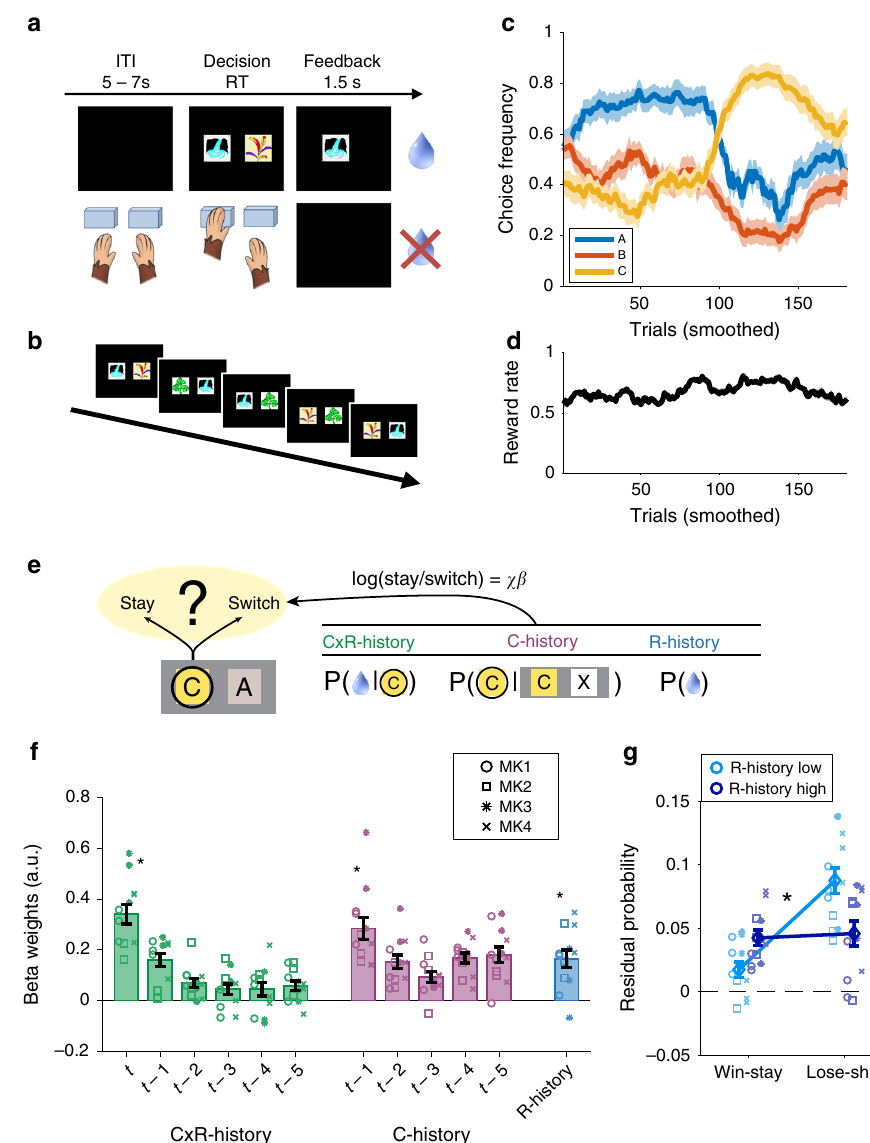
Fig. 1 Task design and behavior. a Monkeys performed a probabilistic binary-choice task for juice reward. b One session comprised three options indicated by different stimuli, only two of which were choosable each trial (experimenter determined, pseudo-random). c Smoothed choice frequency (moving window of 20 trials) followed the reversal in reward probabilities of two of the three options (blue and yellow). d The smoothed overall average reward rate (moving window of 20 trials) fl uctuated continuously over the course of the session. e Illustration of GLM analysis. For every trial we predicted whether the chosen option (C in this example) would be repeated on the next occasion it was presented using three sets of regressors. The fi rst set re fl ected the reward probability of C if it was chosen (CxR-history), the second set re fl ected the tendency to choose C in the past if it was one of the offered options (C-history), and the third re fl ected the global reward state unrelated to a speci fi c choice (R-history). f Signi fi cantly positive effects of CxR-history, C-history, and R- history on the decision to stay with an option. g Residual probability of making a stay or switch choice. Stay/switch behavior was consistent with the outcome (win/lose) on trial t, but the effect was facilitated if the outcome was in accordance with global reward state: Switching away from an option was more likely if R-history was low, while staying with a rewarded option was more likely in high-reward contexts. (in panels b , d , data related to the MRI experiment is shown as mean values ± SEM across sessions; n = 25; panels f , g concatenate sessions per monkey per experiment resulting in three data points per individual; data are presented as mean values ±SEM across monkey data sets; n = 12; asterisks indicate p < 0.001; we used one-sample two- sided t -tests against zero and analyses of variance). Source data are provided as Source Data fi le. Symbols indicate monkey identity in panels f , g ; MK abbreviates monkey. (Panels a , c are adapted from Chau et al. 19